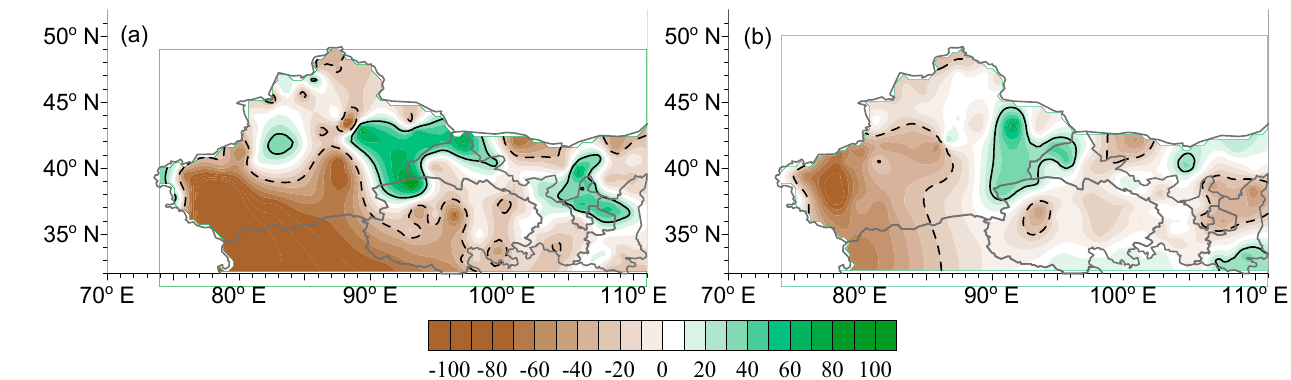
Figure 6. The differences in precipitation in NWC (the shadow represents the percentage of precipitation anomaly; the real (imaginary) line indicates 30% more (less) precipitation): ( a ) spring precipitation; ( b ) summer precipitation.